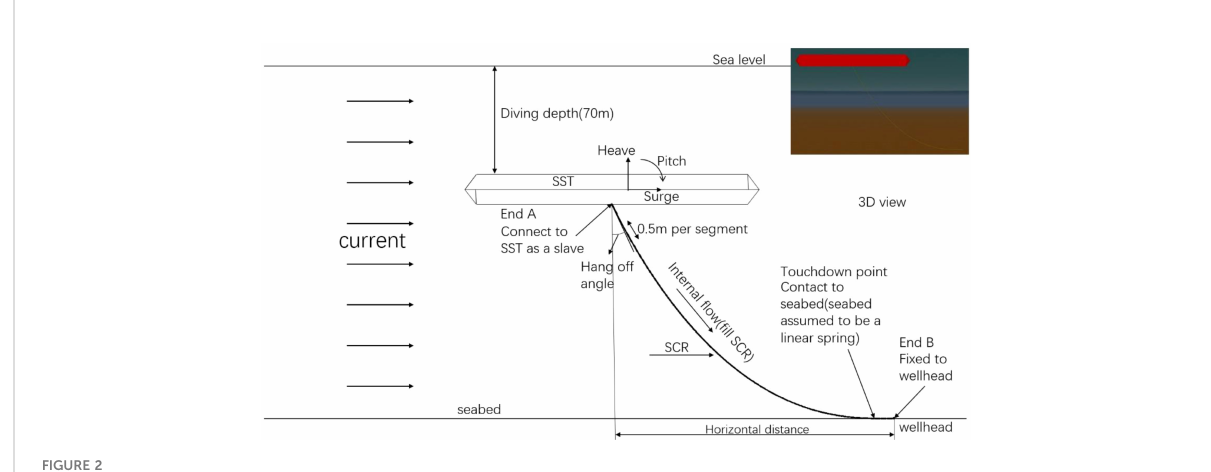
FIGURE 2 Orca fl ex model diagram at case